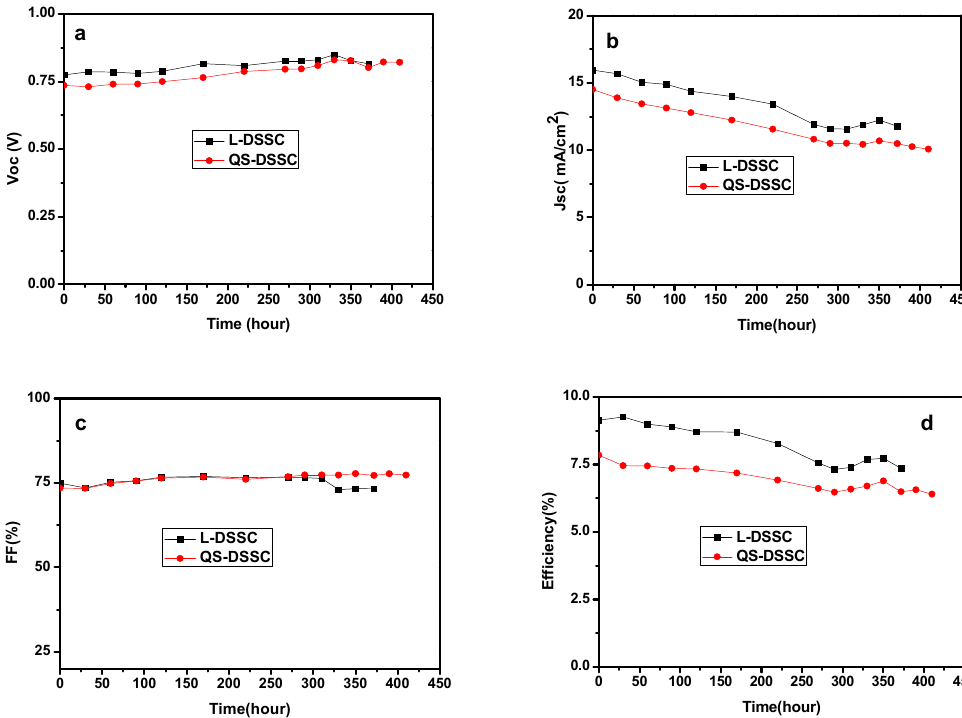
Figure 13. Normalized photoelectric performance of the QS-DSSC and L-DSSC versus time under indoor conditions: ( a ) V OC , ( b ) J SC , ( c ) FF, and ( d ) η .